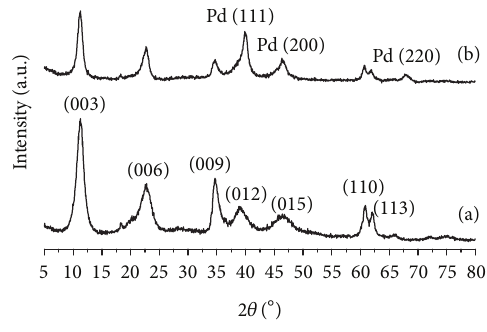
Figure 1: XRD patterns of (a) LDH and (b) Pd/LDH